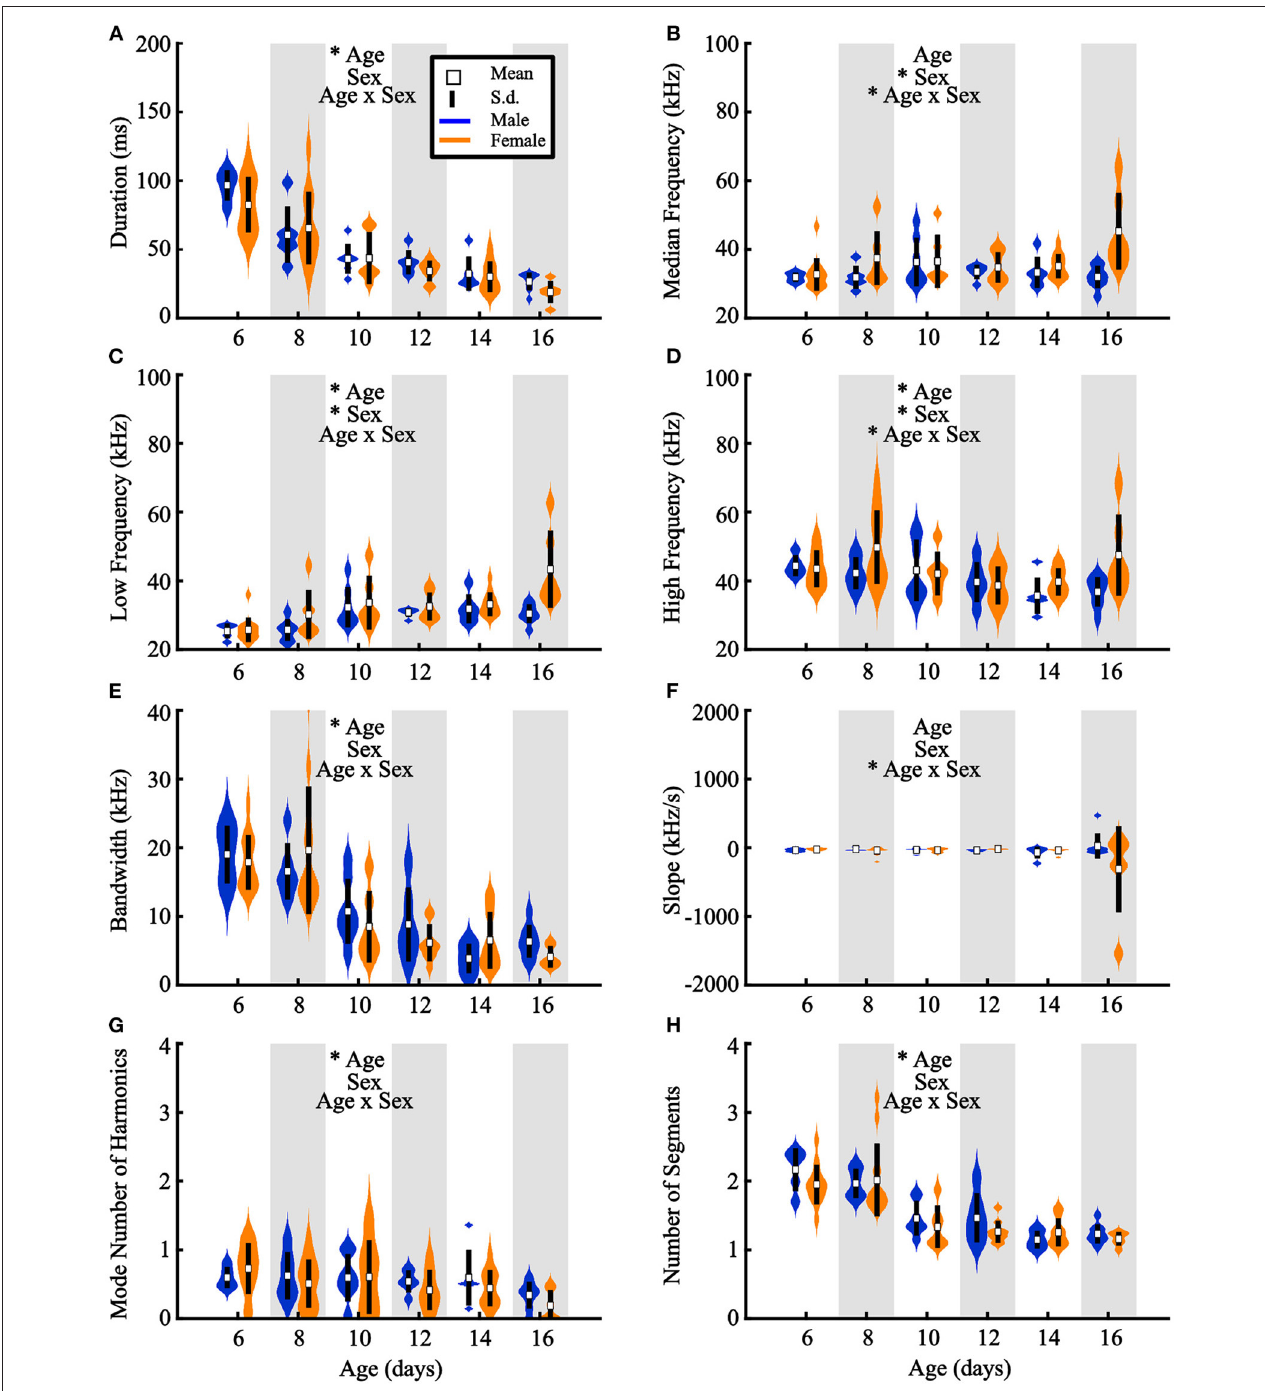
FIGURE 5 | Acoustic features of pup vocalizations differ across development. Individual pups are represented by the average value across all vocalizations emitted by that pup. Violin plots represent feature distributions for (A) duration, (B) median frequency, (C) low frequency, (D) high frequency, (E) bandwidth, (F) slope, (G) number of harmonics, and (H) number of segments per vocalization, sorted by age and sex. Wider locations indicate a higher number of animals exhibiting that average value. *Age = main effect of age, *Sex = main effect of sex, *Age x Sex = significant interaction term (two-way ANOVA). White squares represent group means and vertical black lines represent ± 1 standard deviation. Males are presented in blue, females in orange. * p < 0.05.